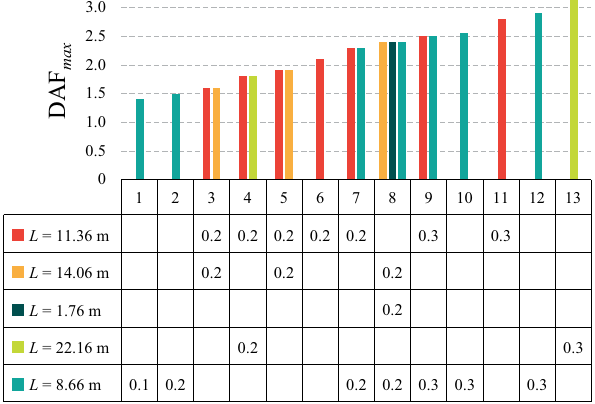
Figure 4. Frame-reinforced beams with diaphragms